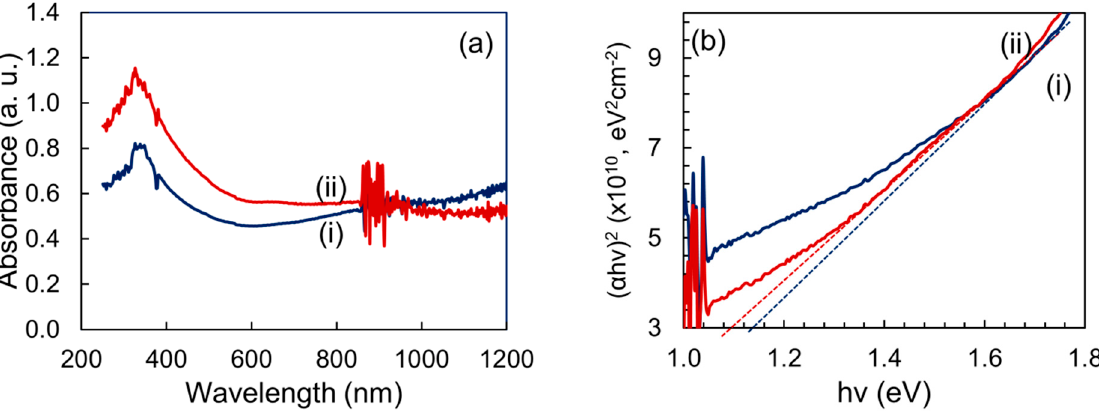
Figure 3. ( a ) Absorbance and ( b ) Tauc plots of PbS nanoparticles synthesized via plant-extract supported method, (i) for 300 °C, and (ii) for 360 °C of calcination temperature. supported method, (i) for 300 ◦ C, and (ii) for 360 ◦ C of calcination